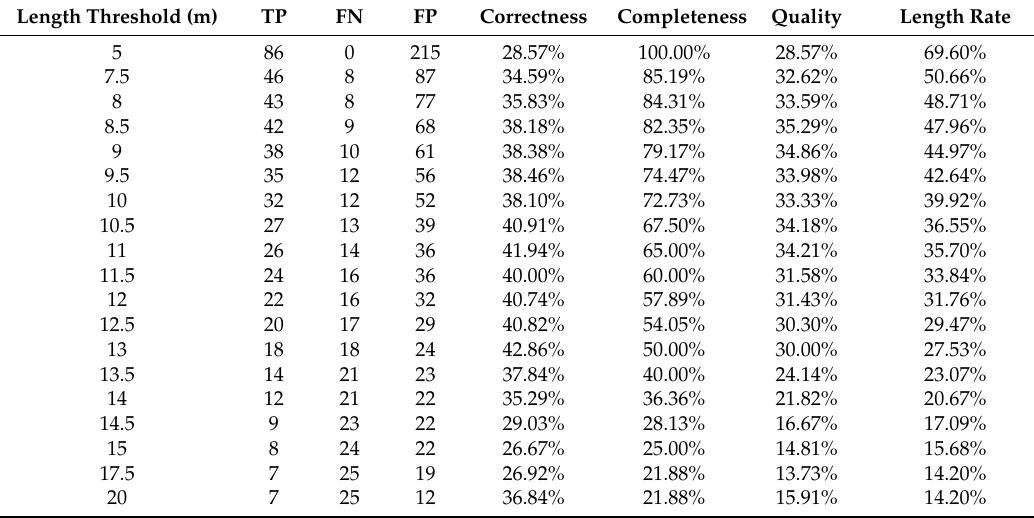
Figure 9. Results of different length thresholds: ( a ) original result of the Canny edge detection; and ( b – f ) are directional detection results with length threshold of 5, 10, 15, 20, and 25 m respectively. Table 2. Accuracy with different length thresholds in the T1 area.